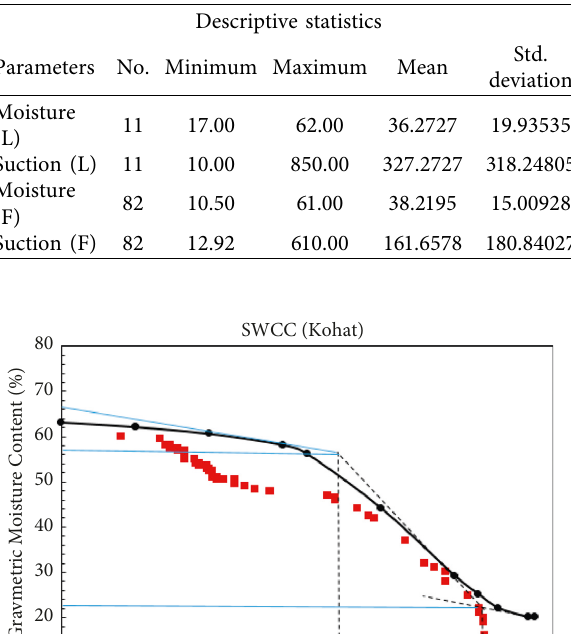
Table 2: Descriptive statistics for the measured parameters of Karak expansive soils.